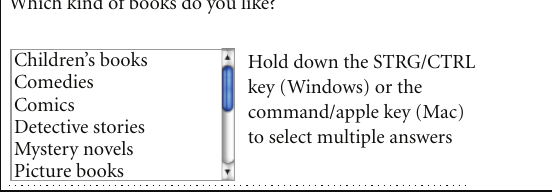
Figure 2: Example for list box condition (translated by the